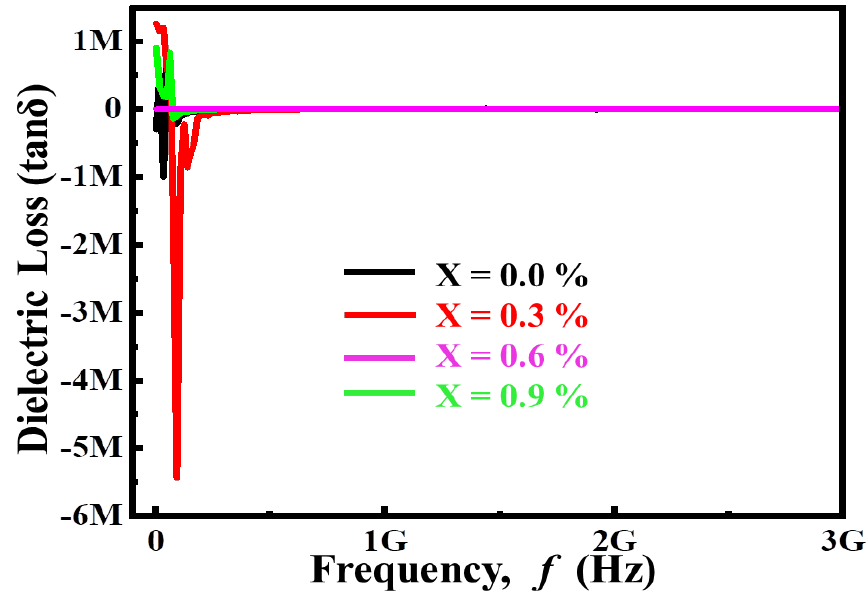
Figure 3. Variation of dielectric loss as a function frequency for (Ba 1 − x Ca x )Ti 4 O 9 (x = 0.0, 0.3, 0.6 and 0.9) sintered ceramics at 1000 °C for 4 h.